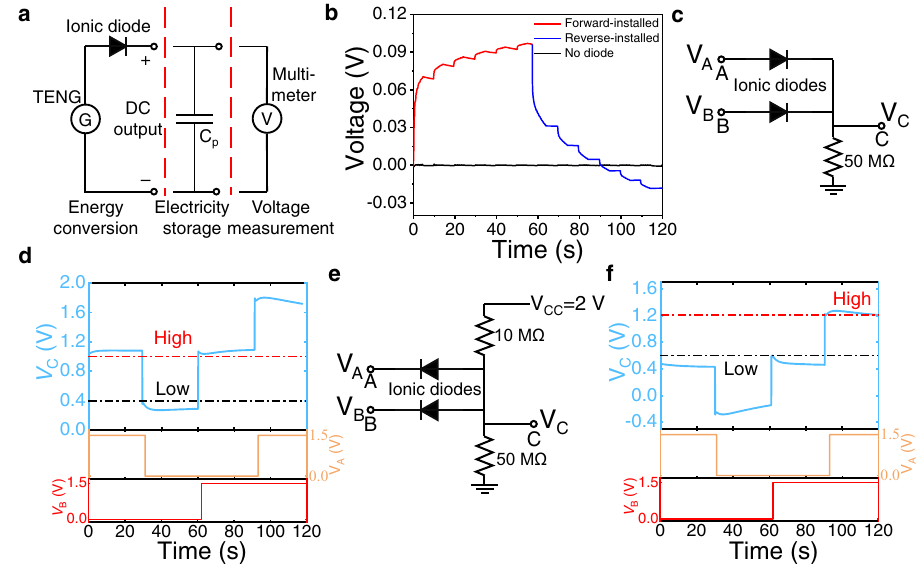
Voltage at C is measured as the output; e a circuit diagram of an ionic AND gate. A and B are the input terminals and C is the output terminal; f performance of ionic ANDgate.SquarewaveswithareprogrammedasbinaryinputsAandBfortheAND gate. Voltage at C is measured as the output.